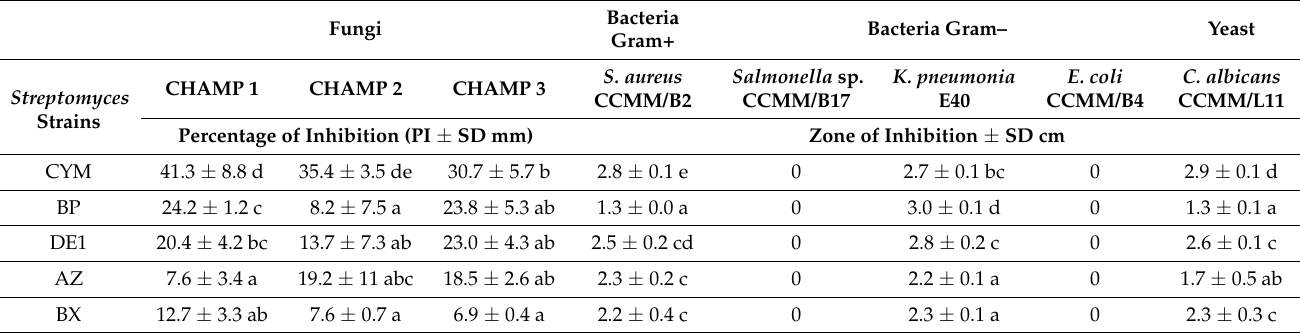
Figure 7. Performance comparison between the five most active Streptomyces spp. (1: DE2; 2: AYD; 3: BYC; 4: AI and 5: AV) against the three isolated phytopathogenic fungi from sugar beet rhizosphere in Beni Mellal, Morocco: ( A ) Fusarium fujikuroi (CHAMP1) and ( B ) F. equiseti (CHAMP2); ( C ) yeast: ( a ) Candida albicans CCMM/L11; pathogenic bacteria: ( b ) Escherichia coli CCMM/B4; ( c ) Salmonella sp. CCMM/B17; ( d ) Klebsiella pneumonia E40; ( e ) Staphylococcus aureus CCMM/B2. Table 1. In vitro antagonistic activities of the ten Streptomyces strains against the three Fusarium isolates from diseased sugar beet roots from Beni Mellal, Morocco: Two Fusarium fujikuroi (CHAMP1; CHAMP3) and F. equiseti (CHAMP2); yeast: Candida albicans CCMM/L11; human pathogenic bacteria: Escherichia coli CCMM/B4; Salmonella sp. CCMM/B17; Klebsiella pneumonia E40; Staphylococcus aureus CCMM/B2; Bacillus subtilis ATCC 9524; Streptococcus sp. CCMM/B24; Pseudomonas aeruginosa CCMM/B90 (zone of inhibition ± SD cm) (percentage of inhibition ± SD mm). Different lowercase letters above bars show significant differences between treatments at p ≤